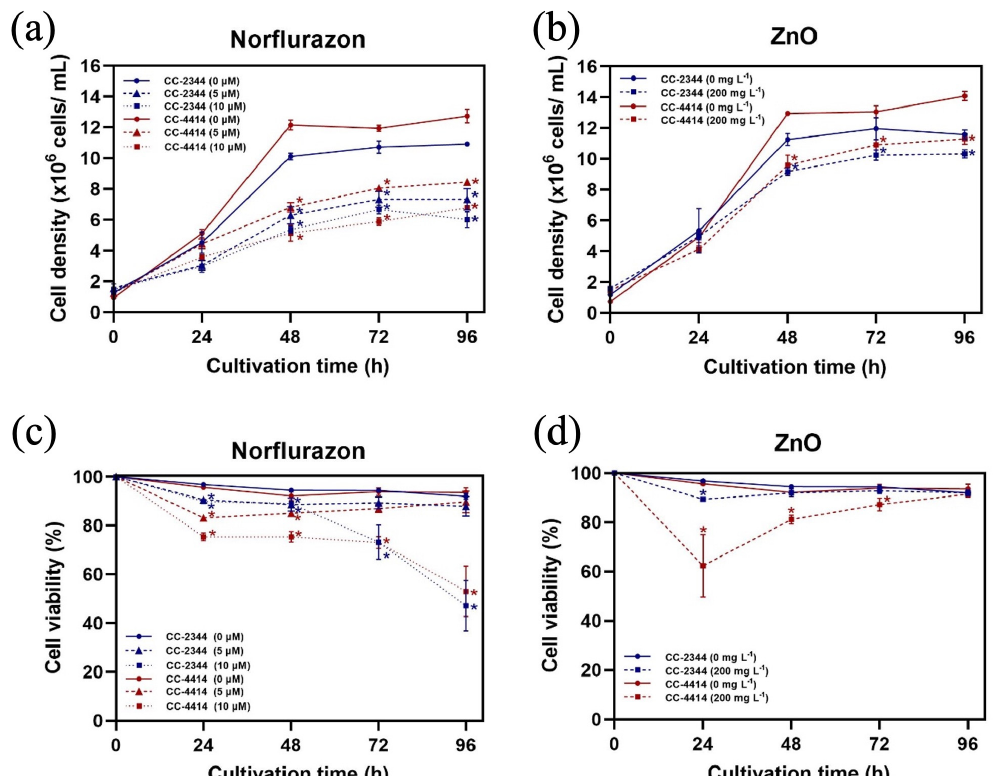
Figure 2. Growth and percentage of cell survival. Cell density ( a , b ) and percentage of cell survival ( c , d ) under norflurazon and ZnO NP conditions, respectively. Blue and red solid lines are CC-2344 and CC-4414 with no chemicals, respectively. Blue and red dashed lines and dotted lines represent CC-2344 and CC-4414 with the indicated concentration of the chemical, respectively. All data are means ± SD of three biological replicates. Significant differences between the control culture and chemical-added culture within the same condition are indicated by asterisks (*) ( p < 0.05).